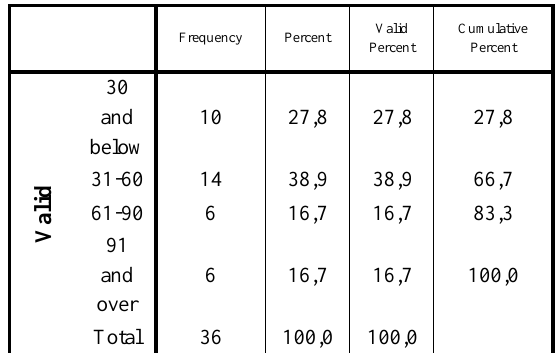
Table 7: Number of Clients